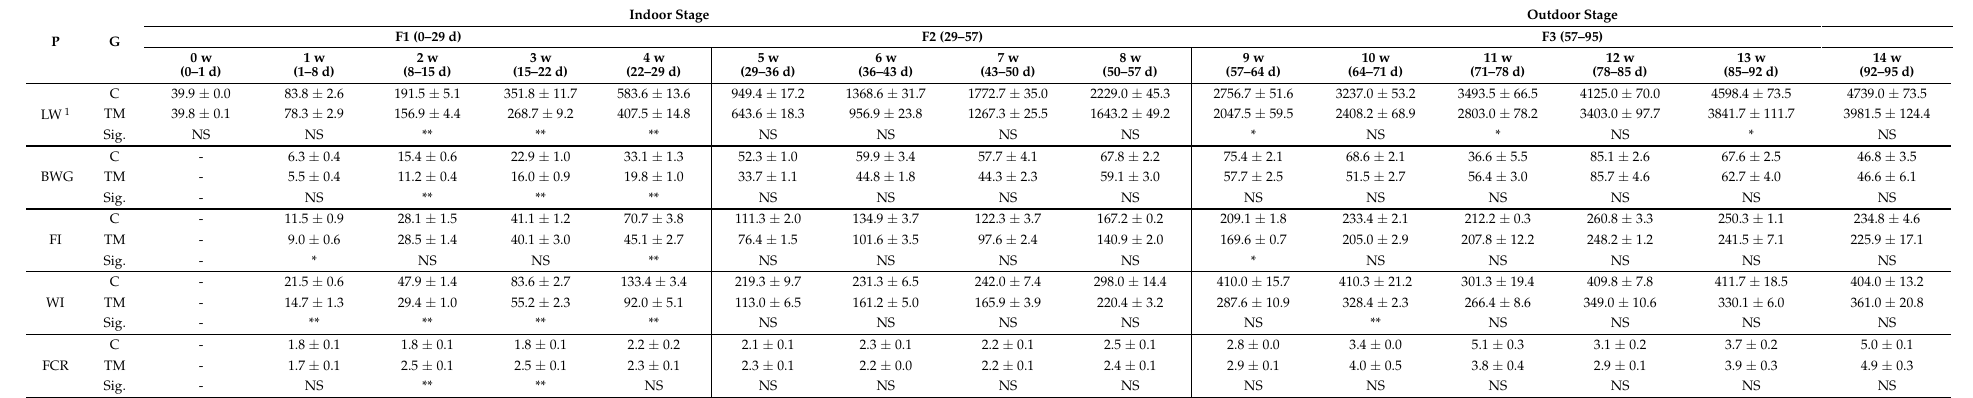
Table 4. Weekly production performance parameters of the two studied chicken groups (C and TM) for the three different diets (mean ±